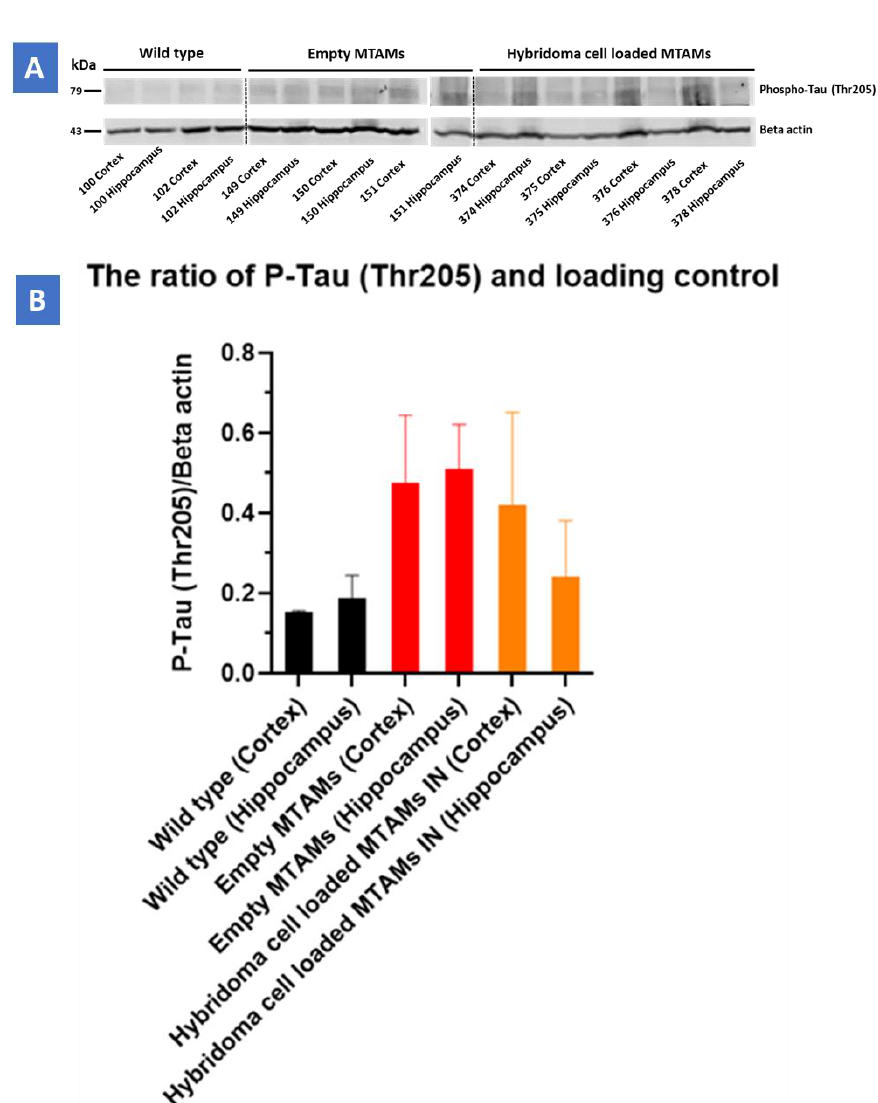
Figure 8. (A) Western blot of the respective study groups of the cortex and hippocampus regions targeting the P-Tau protein (79 kDa) and beta-actin (49 kDa). (B) Triple-transgenic (3xTg) mice with hybridoma cell loaded PSF MTAM (IN) registered a P-Tau/Beta Actin loading control value at 0.41 ± 0.23 (cortex) and 0.24 ± 0.14 (hippocampus), respectively. Conversely, Triple-transgenic (3xTg) mice with empty PSF MTAM (IN) study group registered the highest values at 0.48 ± 0.17 (cortex) and 0.51 ± 0.11 (hippocampus), respectively, while the wild-type C57BL/6J mice without treatment registered the lowest corresponding values at 0.15 ± 0 (cortex) and 0.16 ± 0.06 (hippocampus).